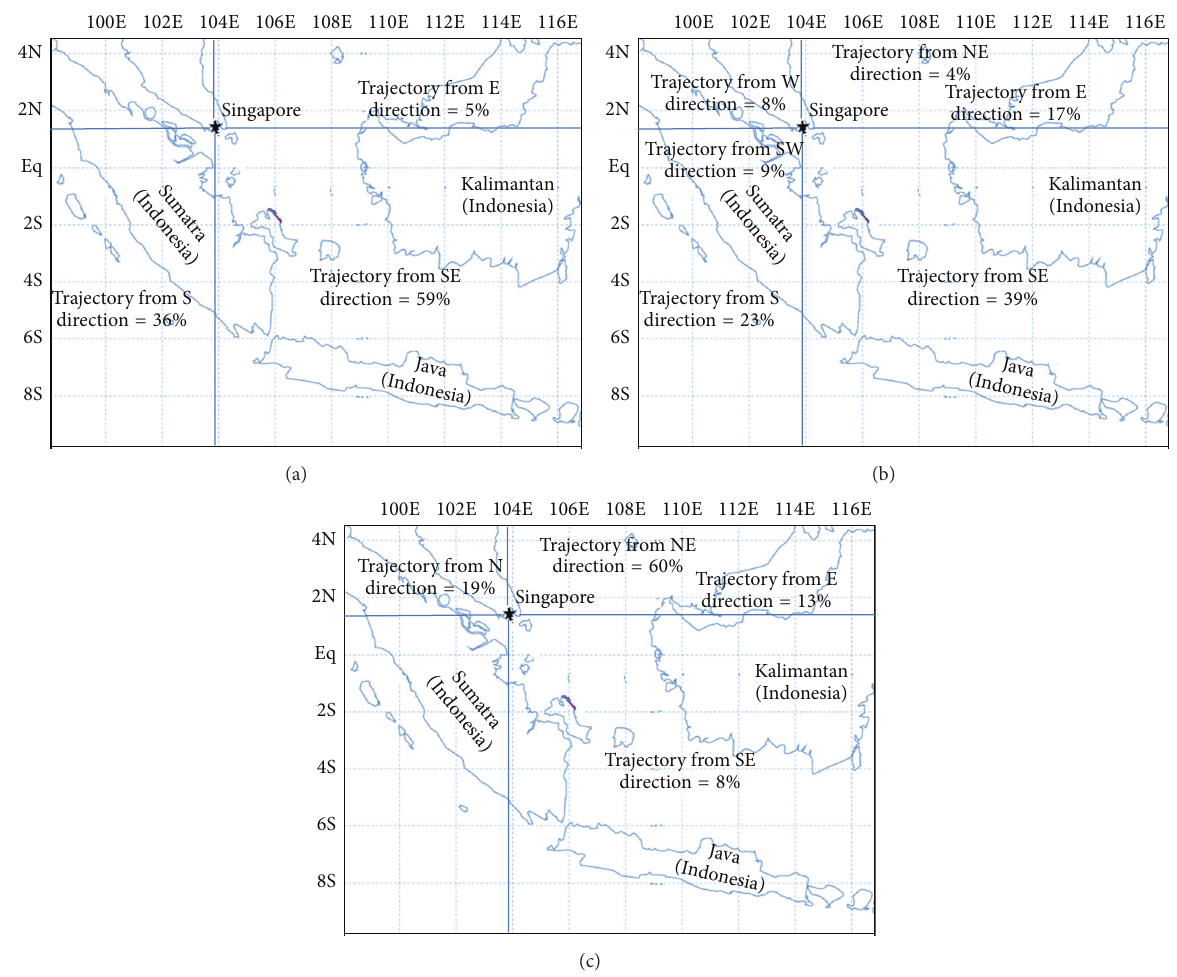
Figure 5: Distributions of 2-day back trajectories ending at Singapore during (a) prehaze, (b) haze, and (c) posthaze periods.